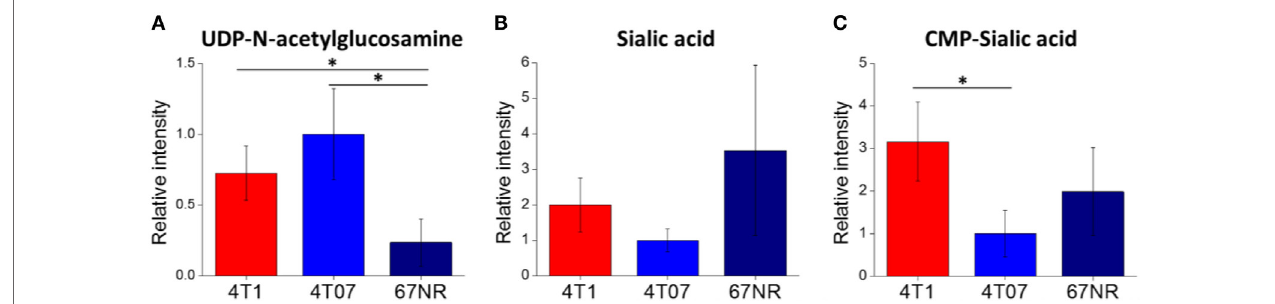
FigUre 3 | Cytidine monophosphate (CMP)-sialic acid is accumulated in highly metastatic 4T1 cells. 4T1, highly metastatic cell line; 4T07, less metastatic cell line; 67NR, non-metastatic cell line. All three cell lines were derived from the same BALB/c spontaneous mammary tumor. Metabolite abundances of (a) uridine diphosphate (UDP)-N-acetylglucosamine, (B) sialic acid, and (c) CMP-sialic acid are represented by peak intensities and are displayed relative to 4T07 averages for clarity. Values are the average of three biological replicates. Error bars represent SD. Statistically significant differences ( p -value < 0.05) are marked with asterisks